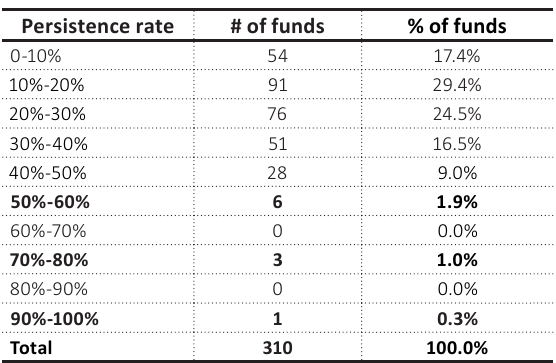
Table 3. Summary statistics of persistence rates